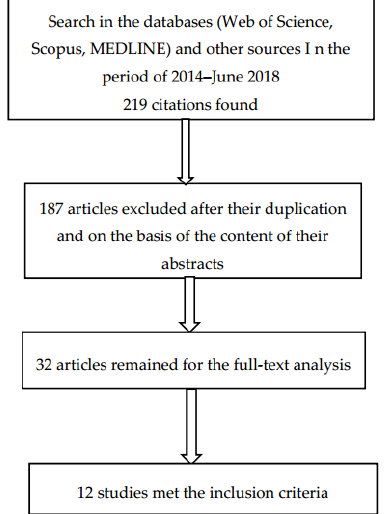
Figure 1. An overview of the selection procedure.